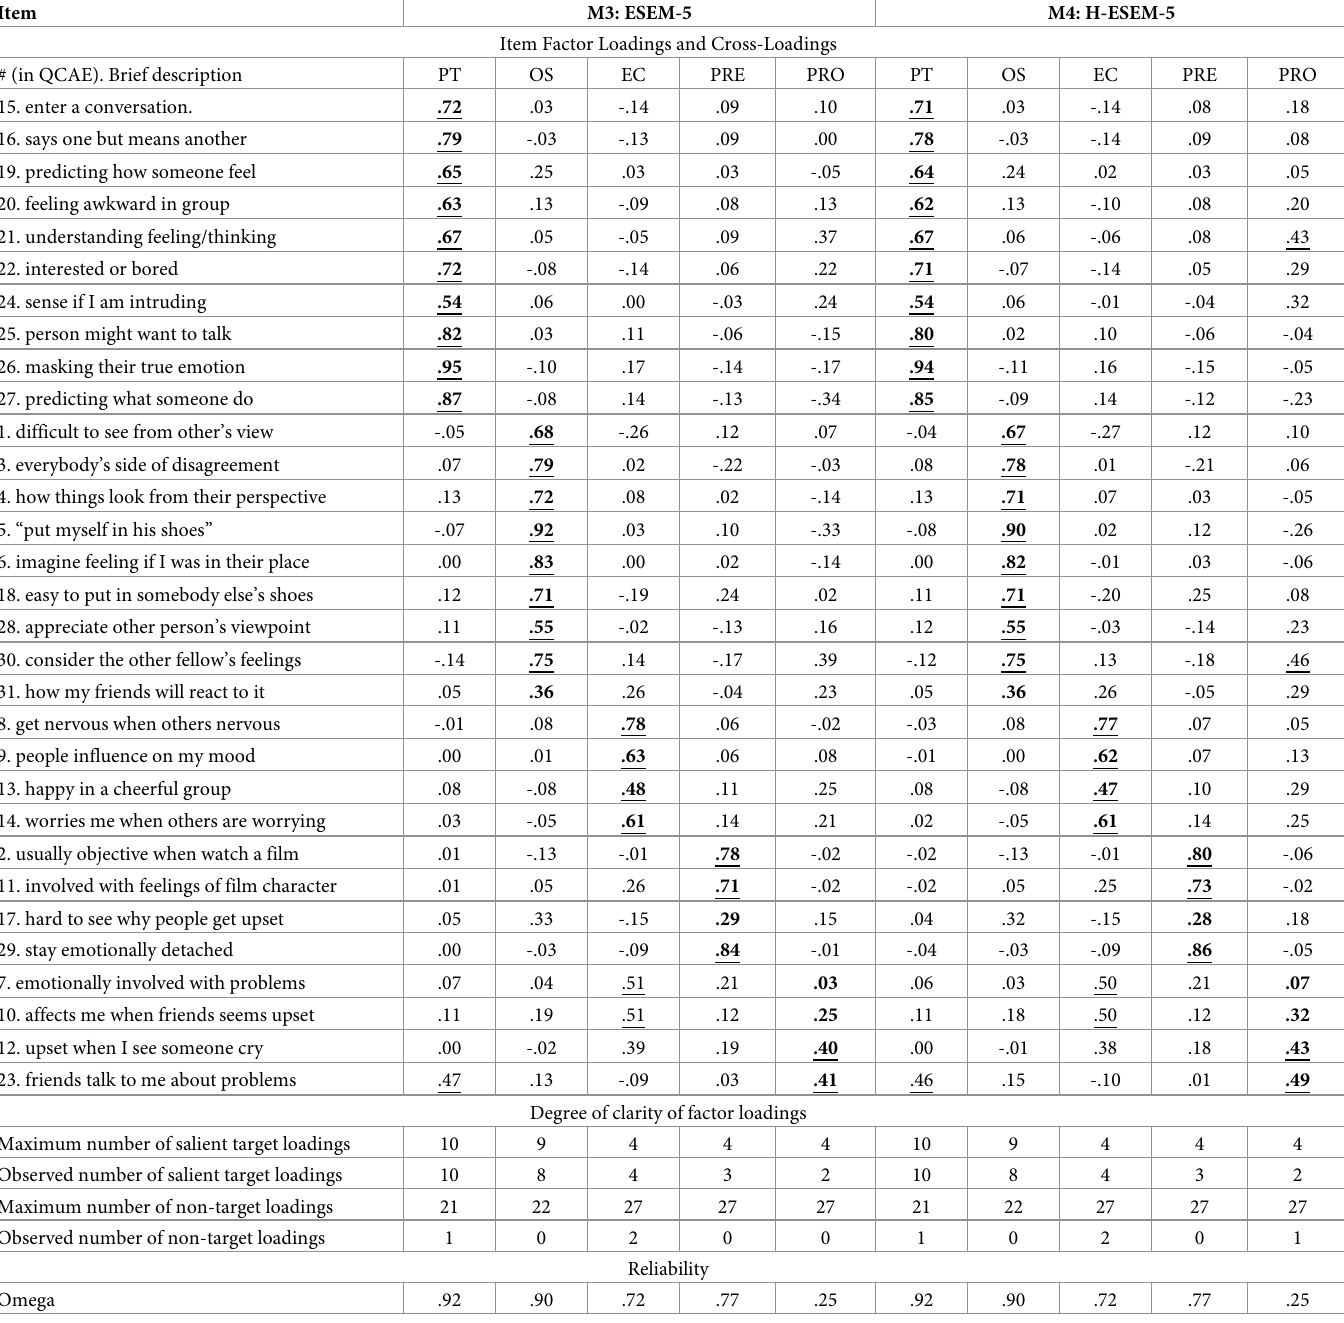
Table 2. Item factor loadings, cross-loadings and factor reliabilities for the QCAE ESEM-5 and H-ESEM-5